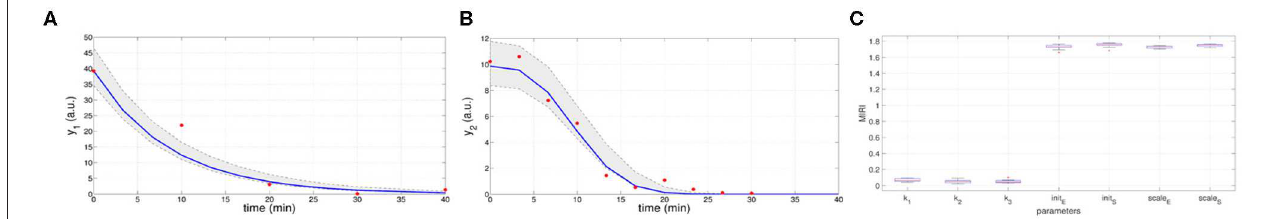
FIGURE 3 | Results of CRC for model M2. (A,B) Time behavior of output variables. Red dots are the noisy experimental data [45]; blue lines are the simulations of the observables of the model when the parameter vector is set equal to the mode p ζ m ; gray regions are the confidence bands when parameter values are chosen between ( p ). (C) Boxplots of the MIRIs in output from the CRA for the seven model parameters the 2.5-th and 97.5-th percentile of their corresponding conditional pdfs f P | P S , ǫ 9 and all the 10 independent